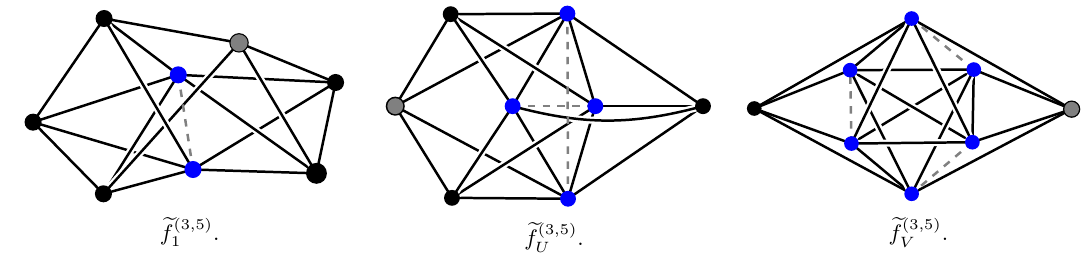
. , e f (3 , 5) , e f (3 , 5) , which are relevant for the 1 U V